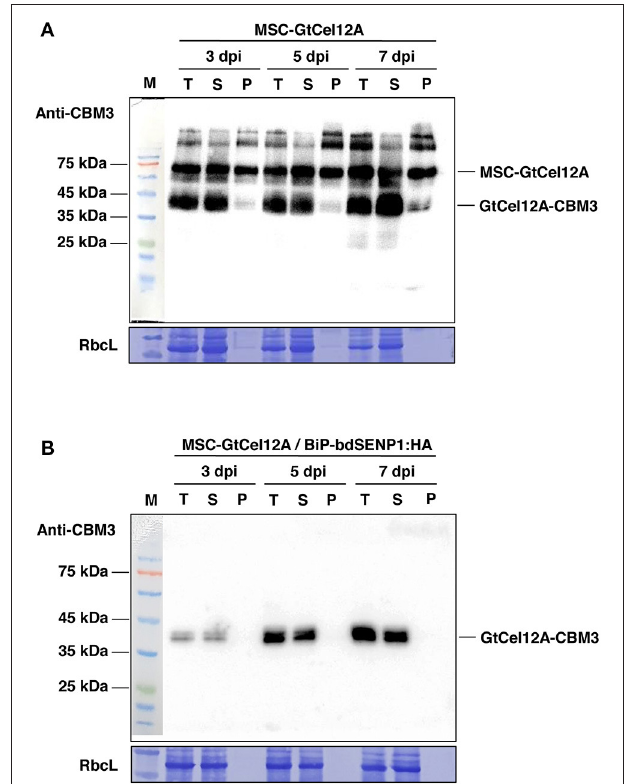
FIGURE 2 | Solubility of GtCel12A-CBM3 produced in N. benthamiana. (A,B) Fractionation of total protein extracts prepared from the leaf tissues transformed with the indicated constructs. Total protein extracts prepared from 0.2g of leaves were subjected to centrifugation at 13.000 rpm for 10min. Next, supernatant (soluble) and pellet fractions were collected separately for western blot analysis using the anti-CBM3 antibody. T, total fraction; S, soluble fraction; P, pellet fraction; RbcL, large subunit of the Rubisco complex stained with Coomassie Brilliant Blue